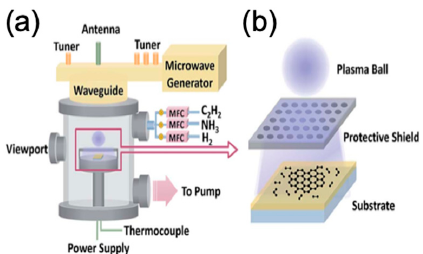
Figure 12. A schematic of ( a ) MW-PECVD setup and ( b ) the zoom-in of the growth of graphene (reprinted with permission from [96]).